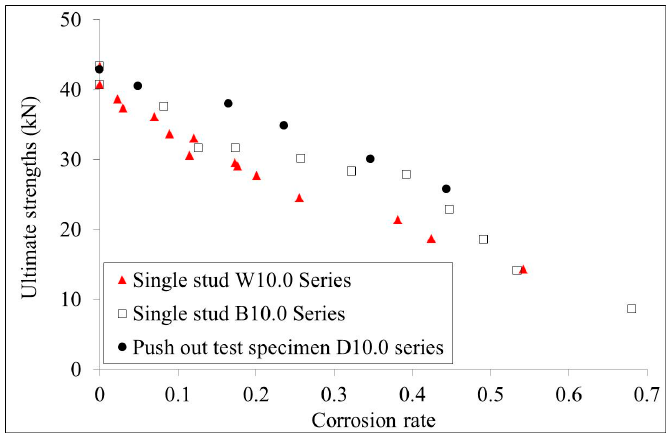
Figure 11. Comparison of the ultimate strengths of the W10.0, B10.0, and D10.0 series specimens.